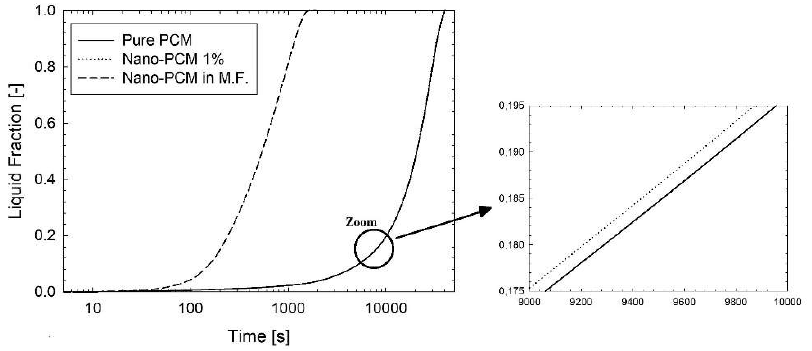
Figure 3. Average liquid fraction evolution during the time for pure PCM, nano-PCM and nano-PCM in metal foam.